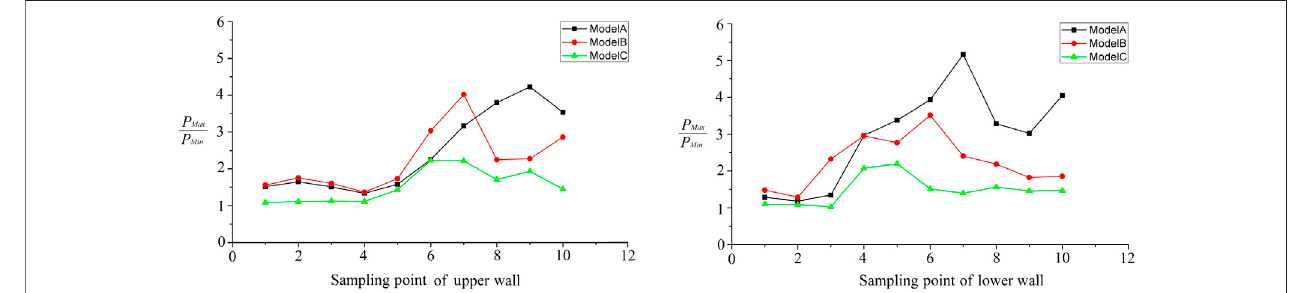
FIGURE 11 | Comparison of the maximum amplitude at sampling